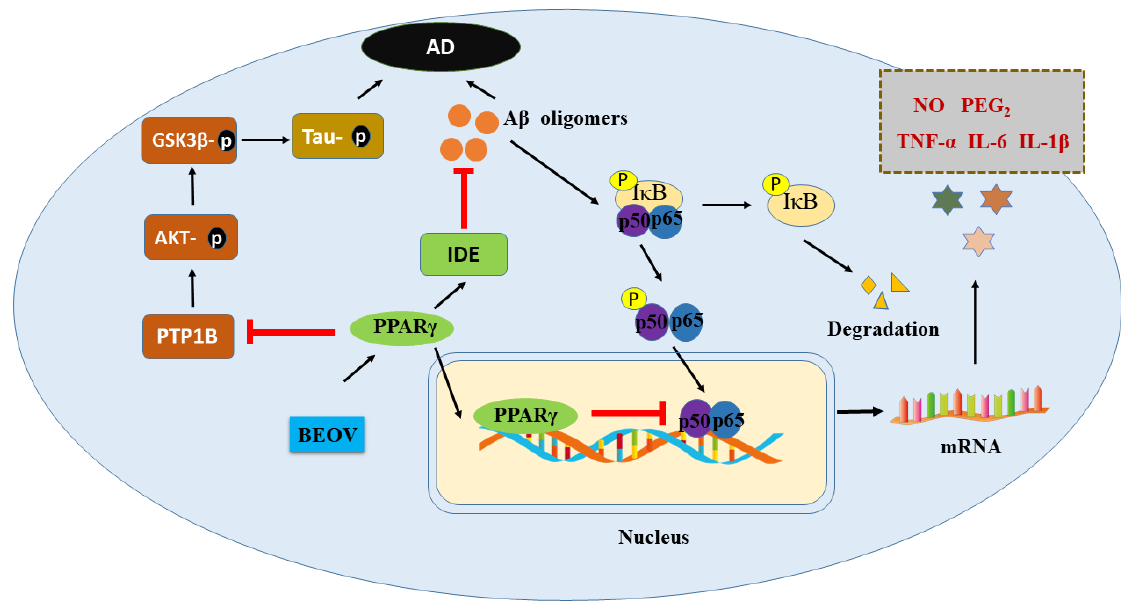
Figure 2. Schematic illustration of the potential mechanism underlying preventive role of BEOV in AD pathology.